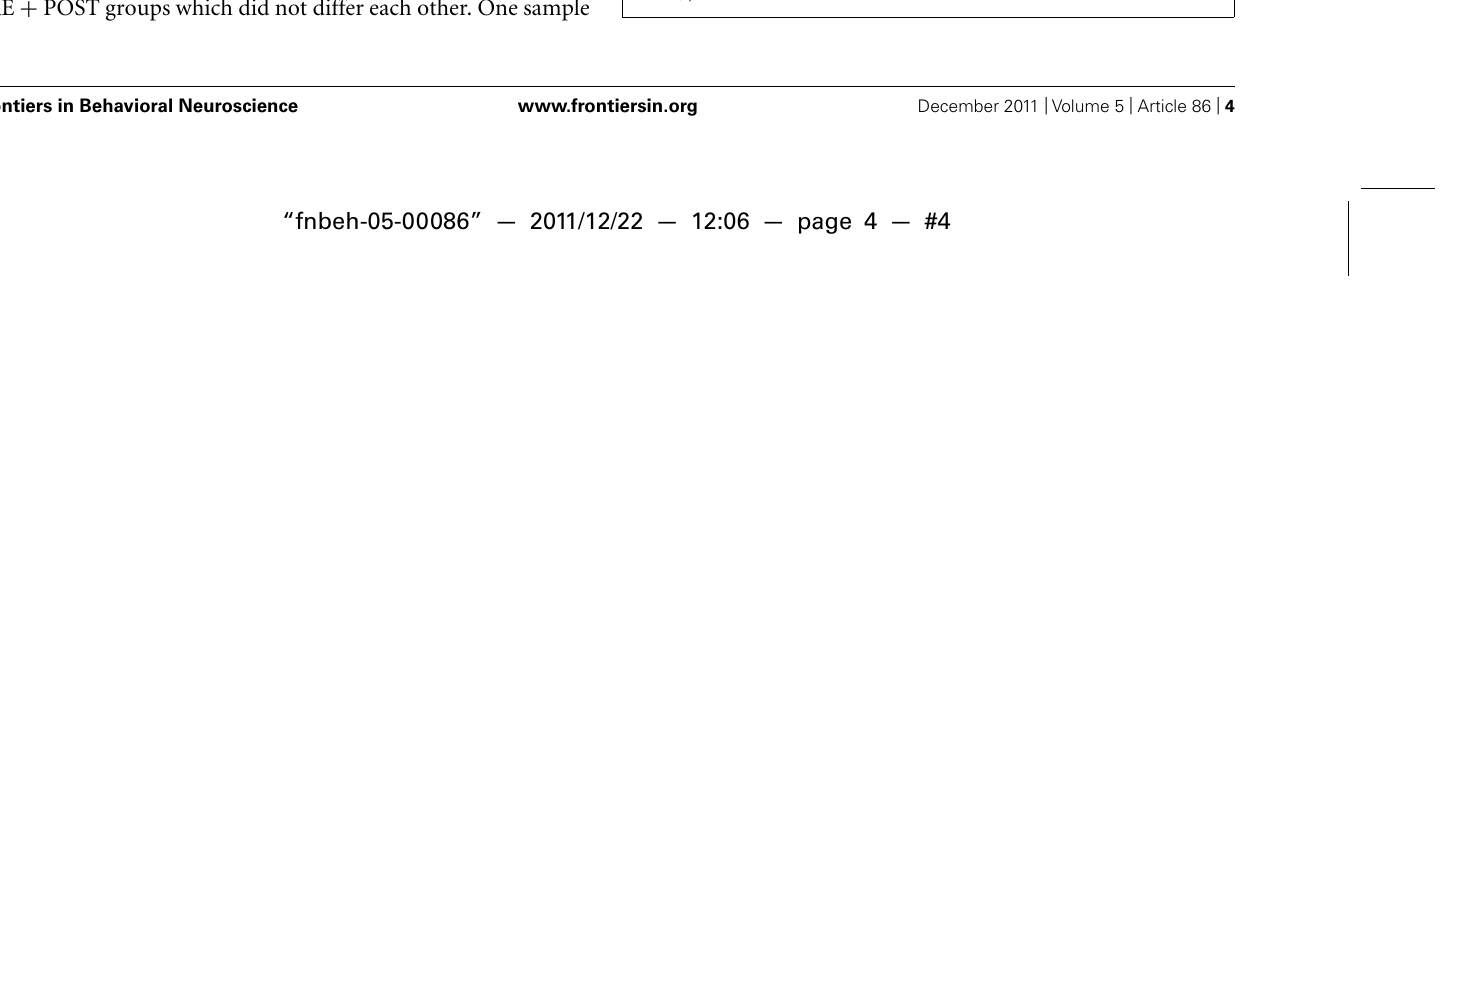
FIGURE 2 | (A) Discrimination index (mean ± SEM) as a function of Rolipram dose (0, 3, and 10 mg/kg) injected immediately after training in the object-paired context measured 96 h post-training (*vs vehicle, p < 0.05; § vs 0, p < 0.01); (B) Discrimination index (mean ± SEM) as a function of Rolipram dose (0 vs 3 mg/kg) injected 120 min after training in the object-paired context measured 96 h post-training (*vs vehicle, p < 0.01; § vs 0, p <